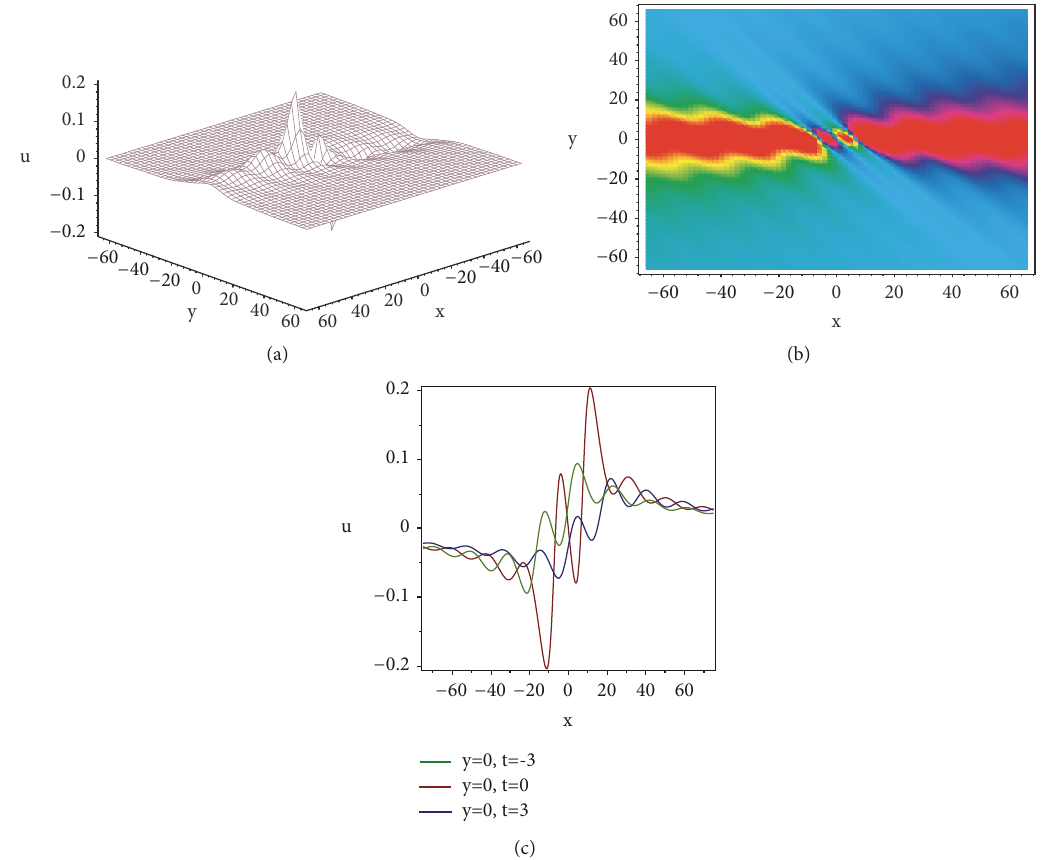
Figure 2: Profile of the interaction between a lump wave and triangular periodic waves in (27). (a) 3-dimensional plot with 𝑡 = 0 , (b) the corresponding density plot, and (c) the curve plot with various values of